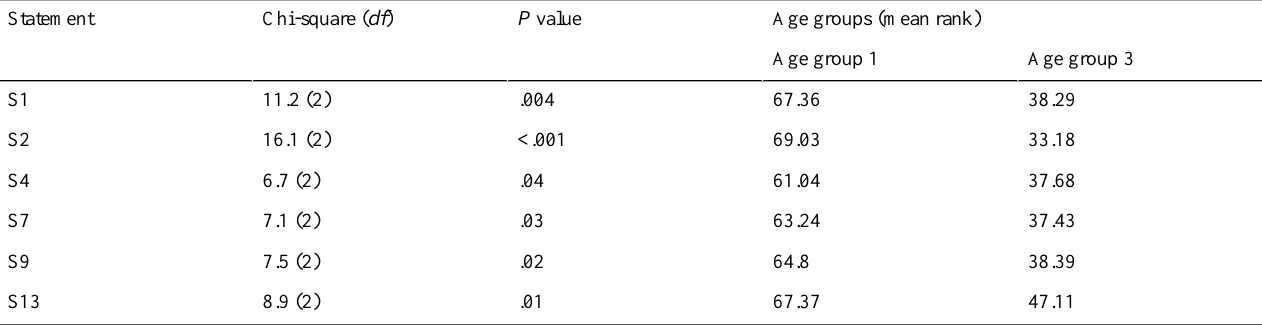
Table 3. Test statistics in the Kruskal-Wallis test on 6 statements among 3 different age